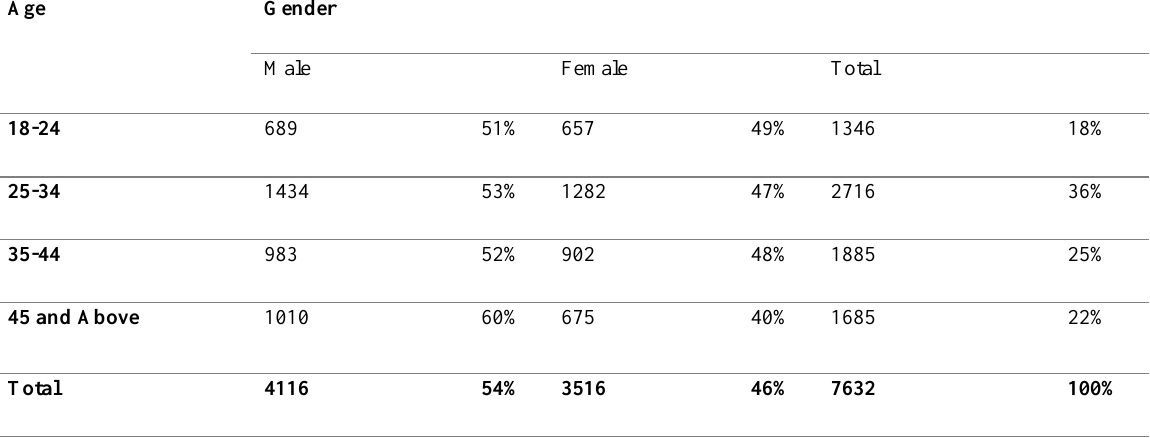
Table 2: Citizen's by age group by sex (N=7632)